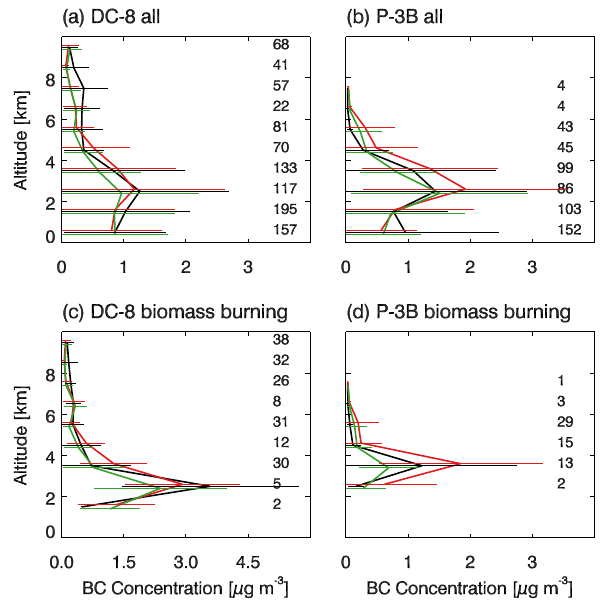
Fig. 7. Vertical profiles of BC concentrations over the northwestern Pacific (south of 25 ◦ N) as measured by aircraft during the TRACE- P campaign and as simulated by the model. The black, red and green lines represent BC concentrations from the aircraft observations, the sensitivity simulation using the MISR injection height profile, and the control simulation, respectively. Upper panel: all air masses sampled by the TRACE-P aircraft (DC-8 and P-3B). Lower panel: air masses significantly impacted by biomass burning. Model re- sults were sampled along the flight tracks (Fig. 3). Measurements and model results were both averaged to the temporal and spatial resolution of the model for comparison. The error bars show the standard deviations. The numbers on the right are the numbers of model grids